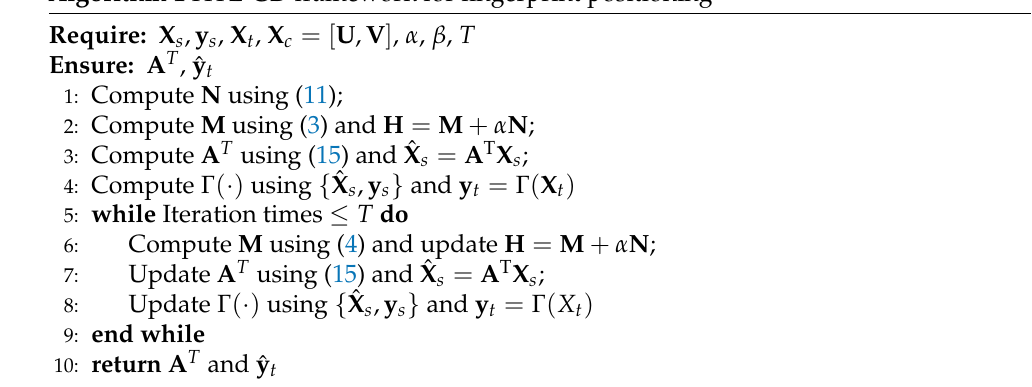
Algorithm 1 HTL-CD framework for fingerprint